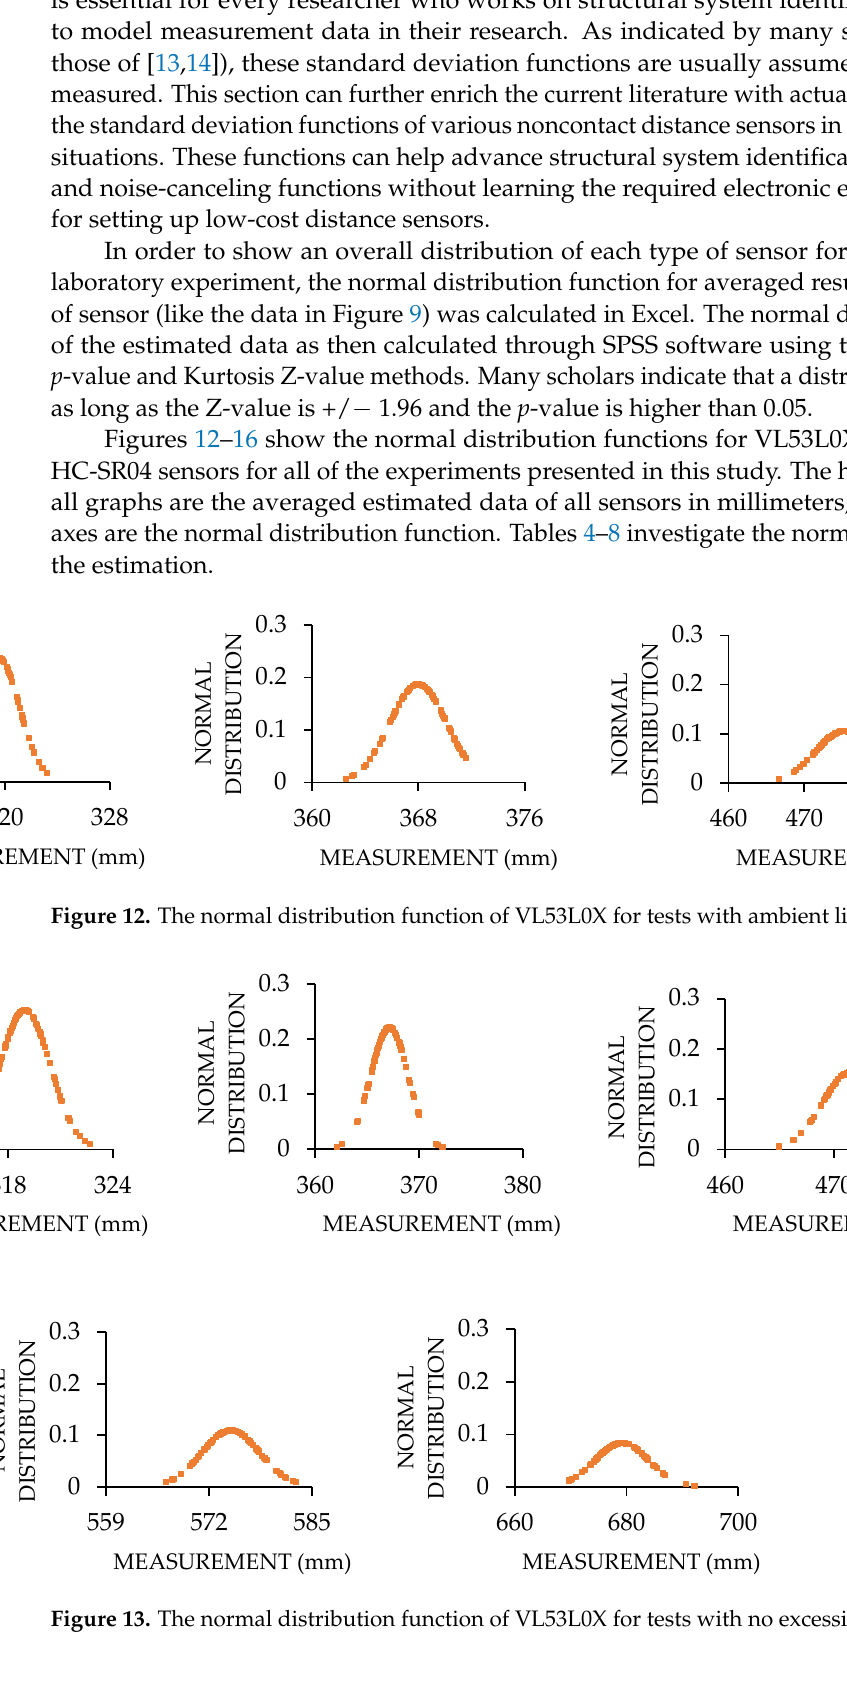
Figure 13. The normal distribution function of VL53L0X for tests with no excessive ambient light. Table 5. Statistical analysis of VL53L0X for tests with no excessive ambient light.